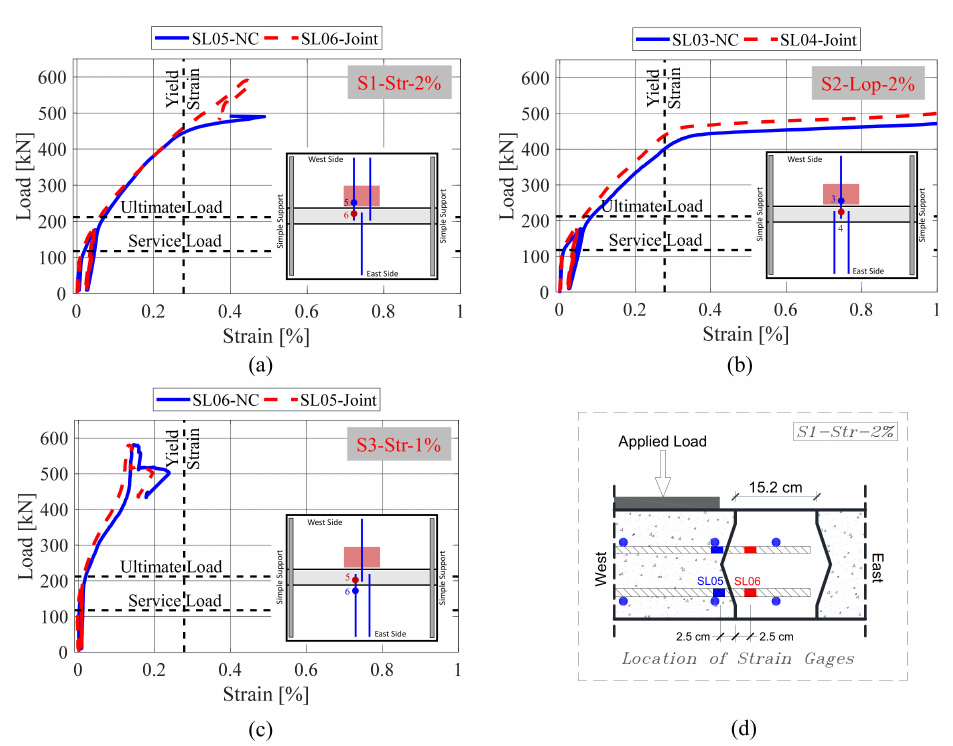
Figure 10. Load versus tensile strains of selected bottom longitudinal reinforcement of